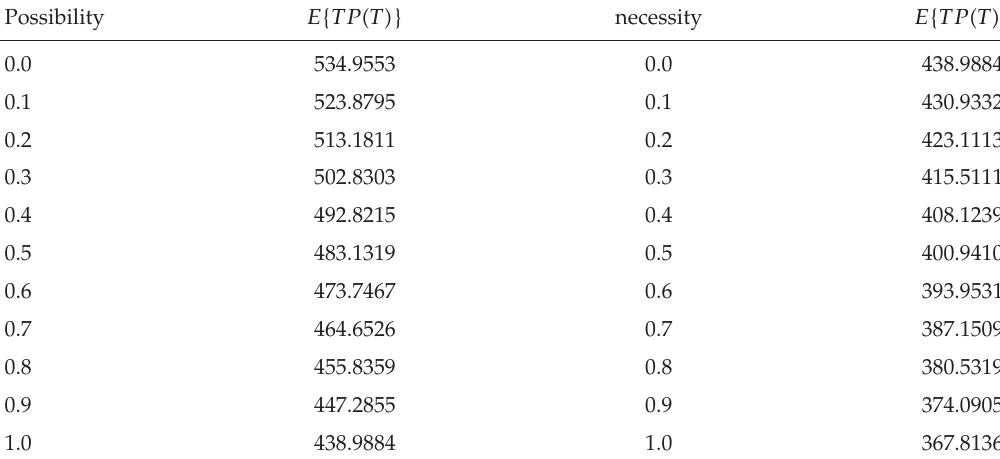
Table 6: Results due to possibility and